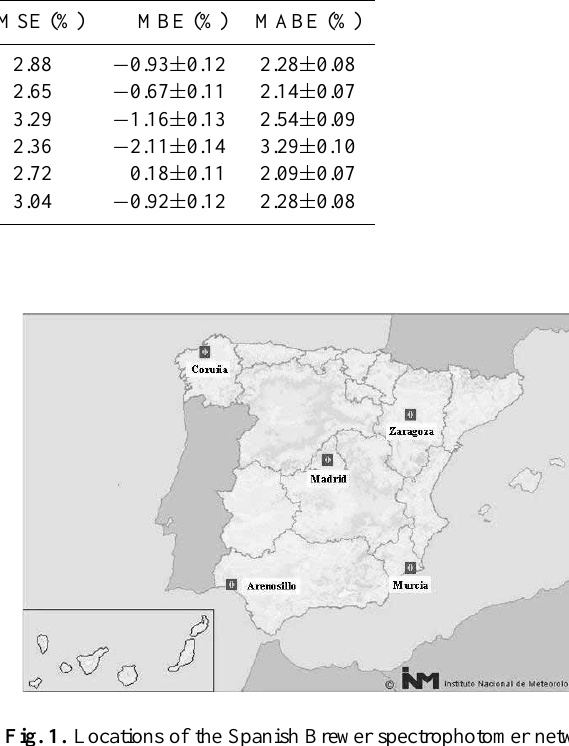
Fig. 1. Locations of the Spanish Brewer spectrophotomer network in the Iberian